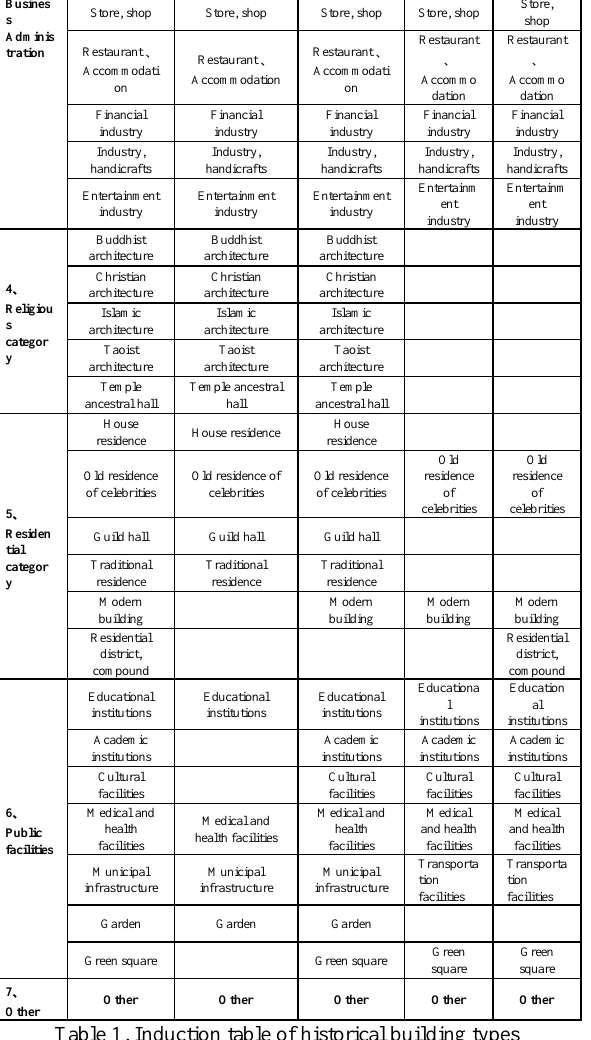
Table 1. Induction table of historical building types